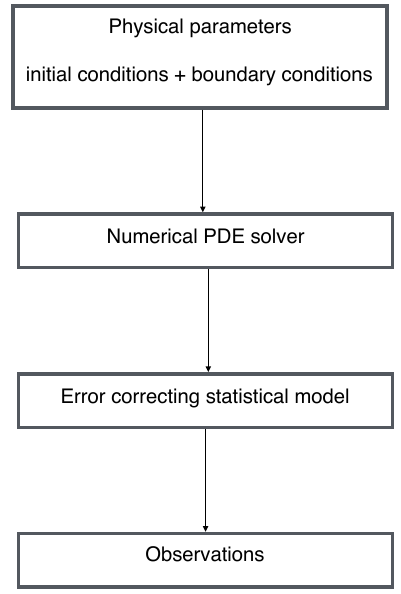
Figure 2. Schematic of a prototypical physical–statistical Bayesian hierarchical model. At the top layer, physical parameters, initial conditions, and boundary conditions are fed into a numerical solver, and the output of this is corrected with an error-correcting process; finally, the actual observations are dependent on the actual physical process